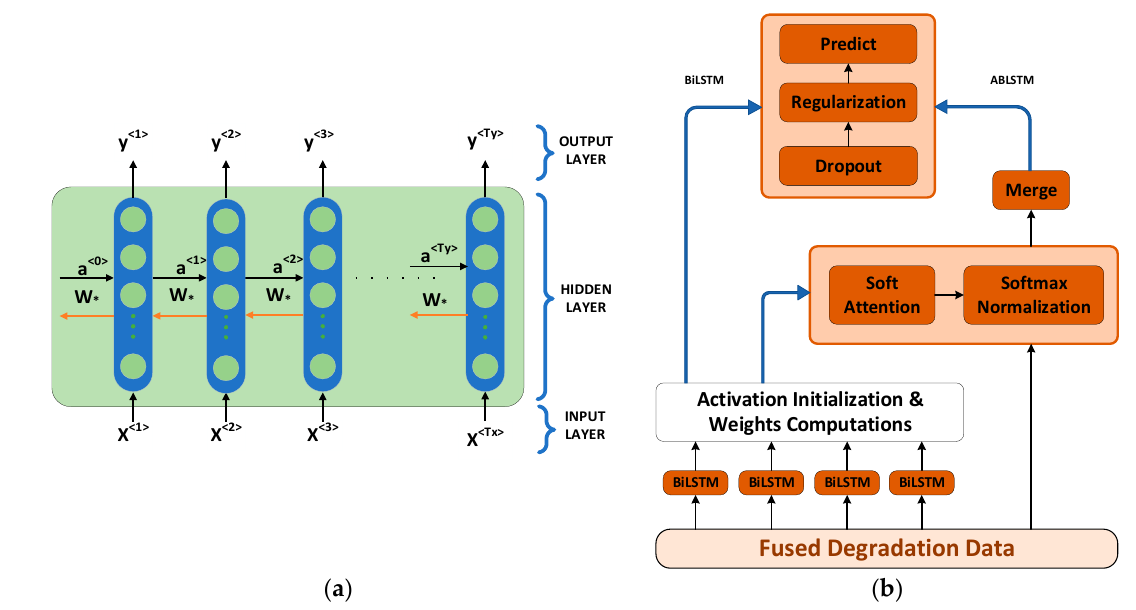
Figure 3. ( a ) A BiLSTM cell. ( b ) Representation of BiLSTM and ABLSTM training. Weights computed from the BiLSTM layer are fed into the attention layer for further com- putation. The weight vector of BiLSTM layer can be expressed as H = { h 1 , h 2 , h 3 . . . . . . h N } . Then, the attention weights and vectors are computed using Equations (19) and (20) [35,36].